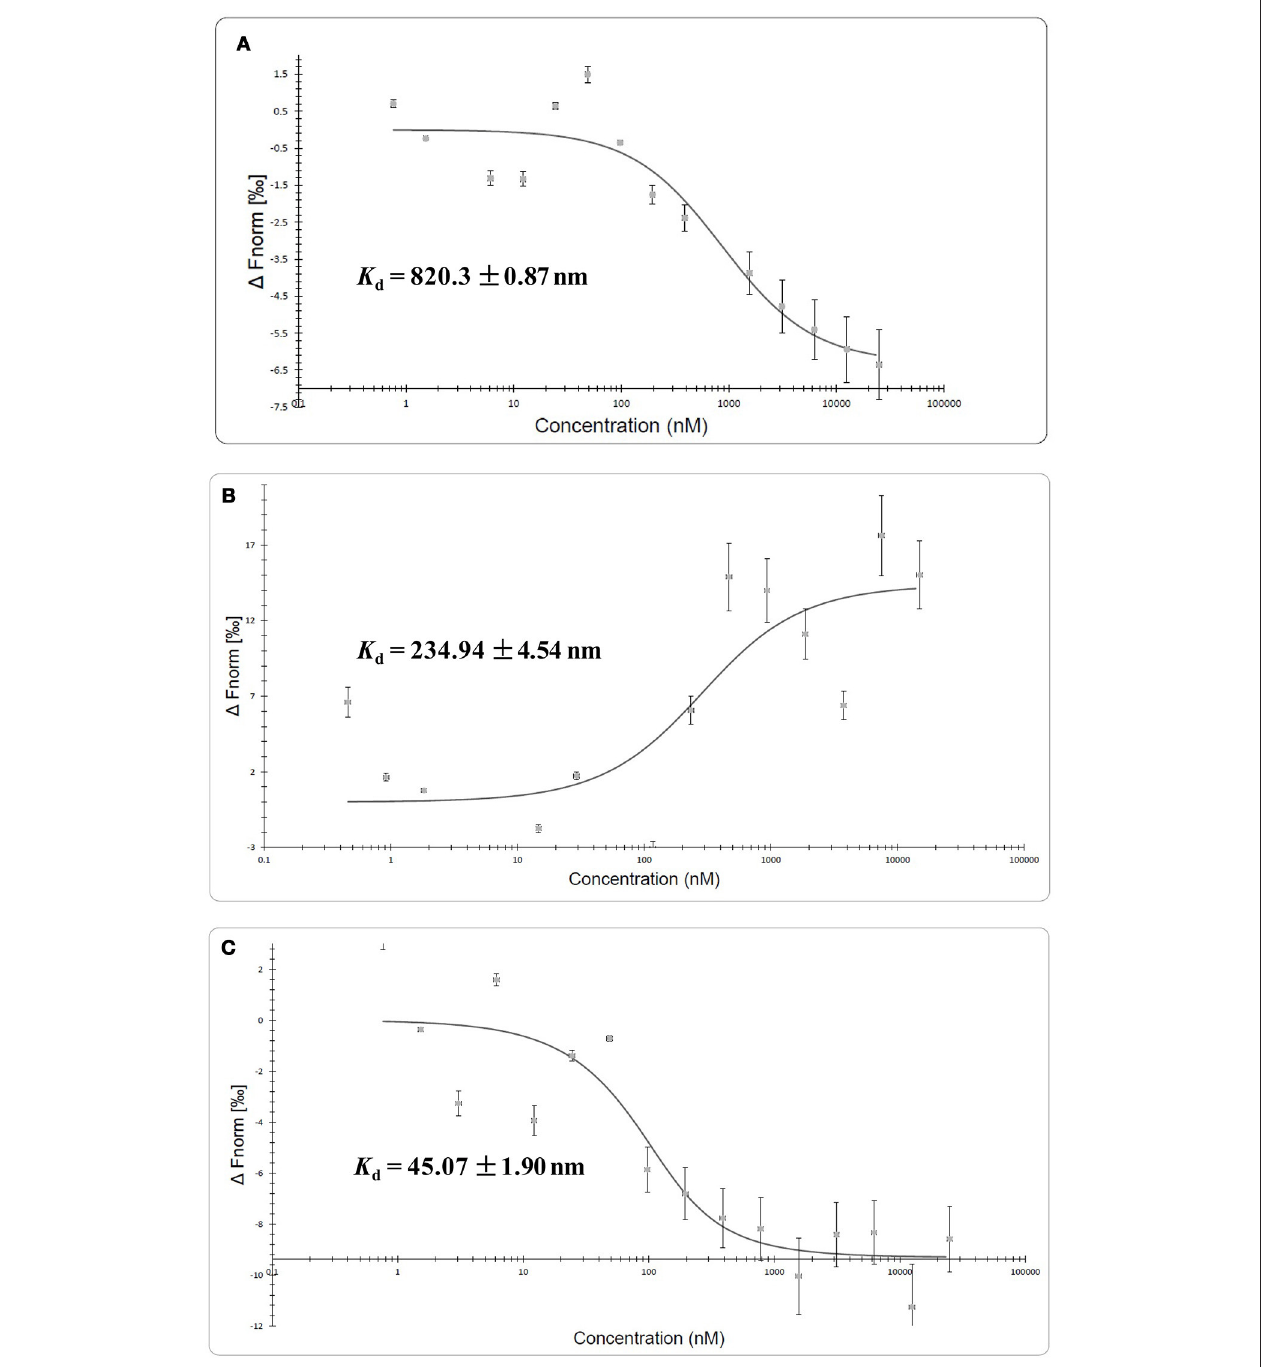
FIGURE 8 | Molecular interaction of QSIs using microscale thermophoresis analysis. (A) Molecular interaction of SPL (B) molecular interaction BN1 (C) molecular interaction BN2. Unfortunately we could not find any such interaction with C7X.